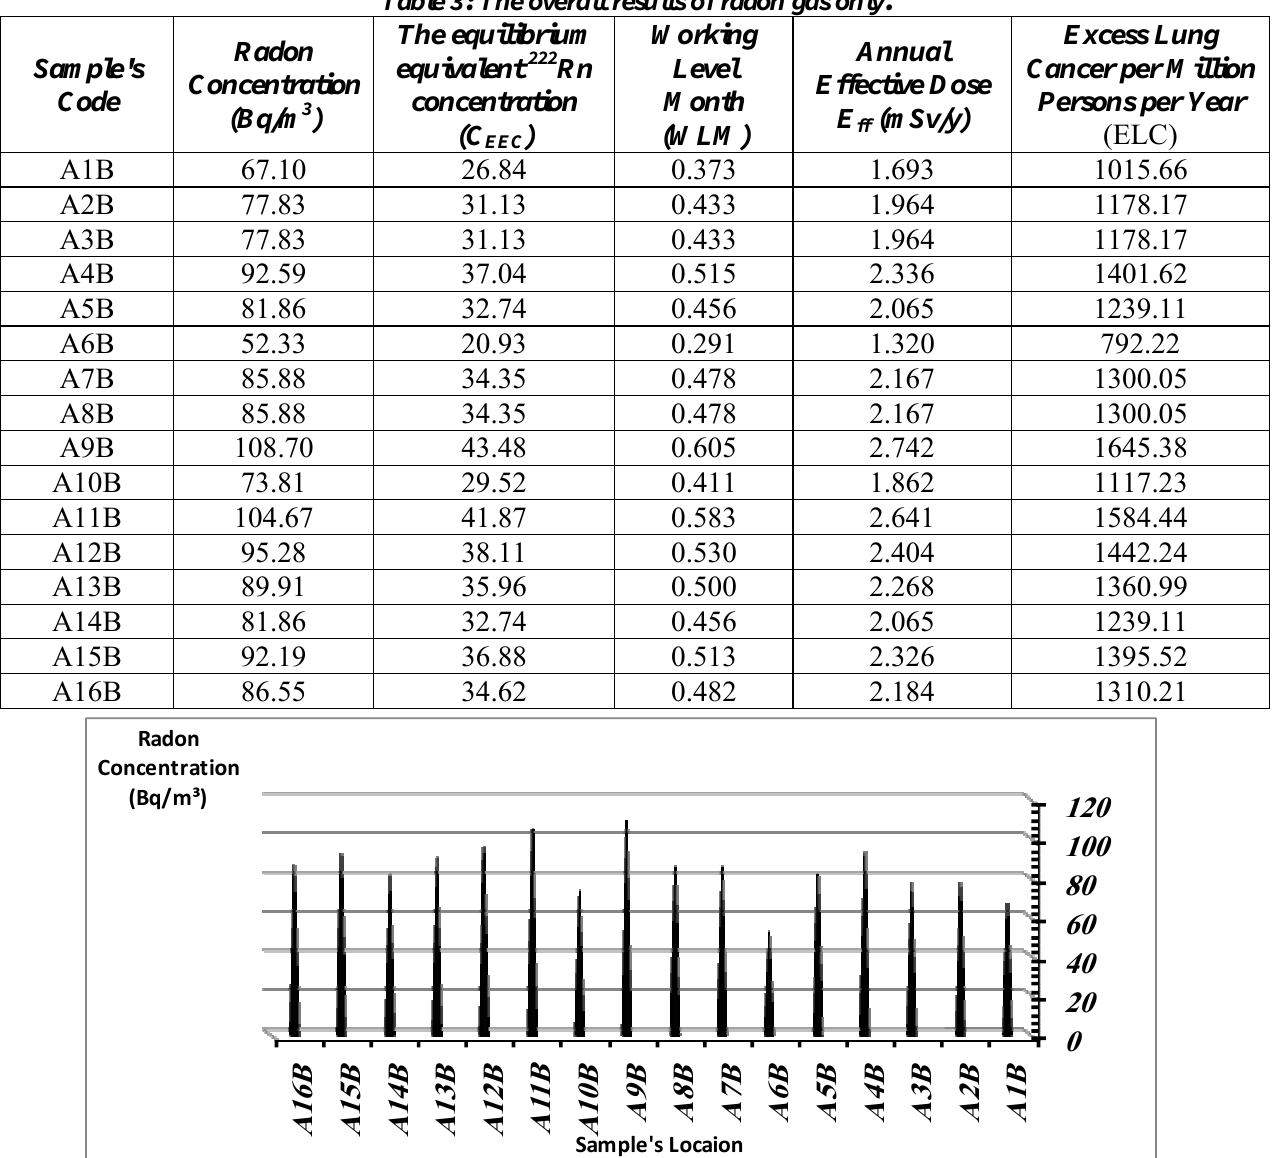
Table 3: The overall results of radon gas only.